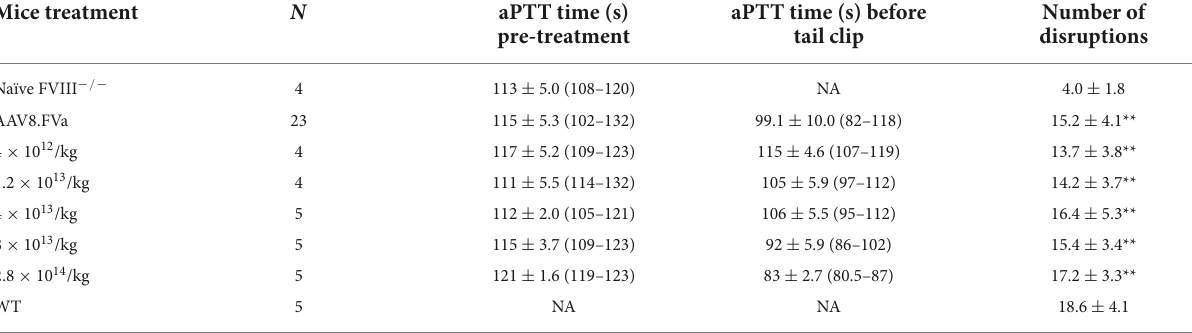
TABLE 2 Phenotypic correction by saphenous vein bleeding assay in FVIII − / − mice treated with different doses of AAV8/hFVa vectors. Mice treatment N aPTT time (s)